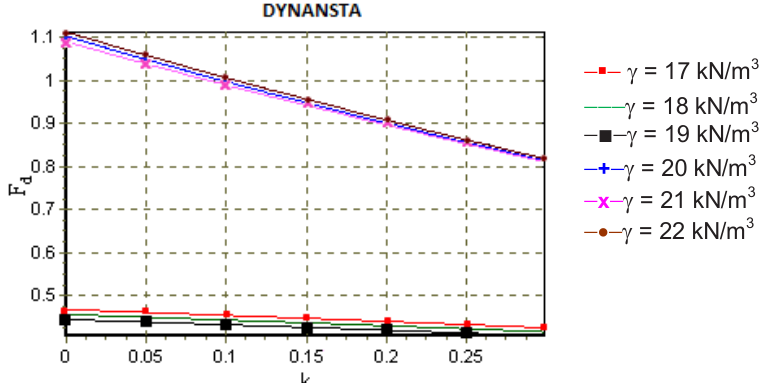
Figure 15: Effect of the upstream unit’s